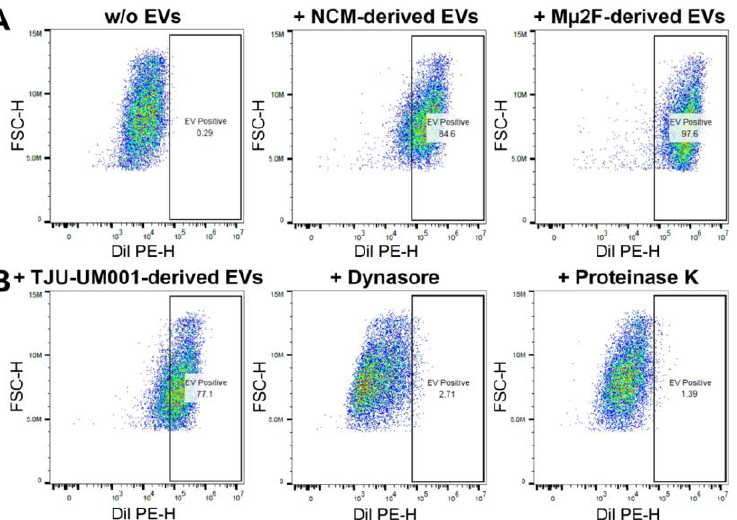
Figure A1. Dynasore and proteinase K pretreatments prevented EV internalization in stellate cells. ( A ) Fluorescence of HSteCs without addition of EVs by flow cytometry. Fluorescence of HSteCs after the addition of DiI-labeled large EVs derived from UM cell lines (Mµ2F, TJU-UM001) or NCMs for 24 h ( A – B ). ( B ) Fluorescence of HSteCs pretreated with Dynasore or after the addition of TJU- UM001-EVs pretreated with proteinase K are shown as controls. The gates indicate the percentage of fluorescent HSteCs.